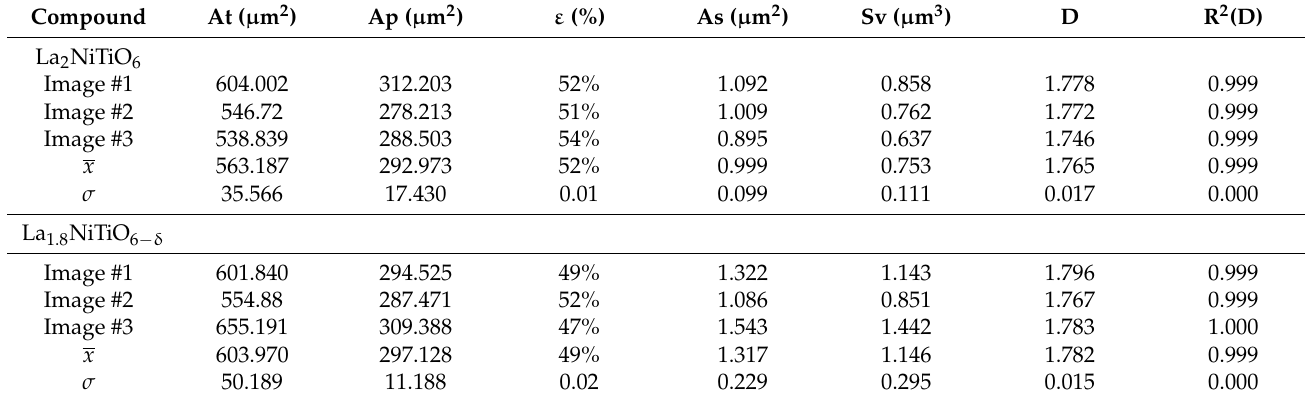
Table 2. Geometrical analysis of electrode surface from SEM images in LNT and L18NT electrodes; x , mean value; σ , standard